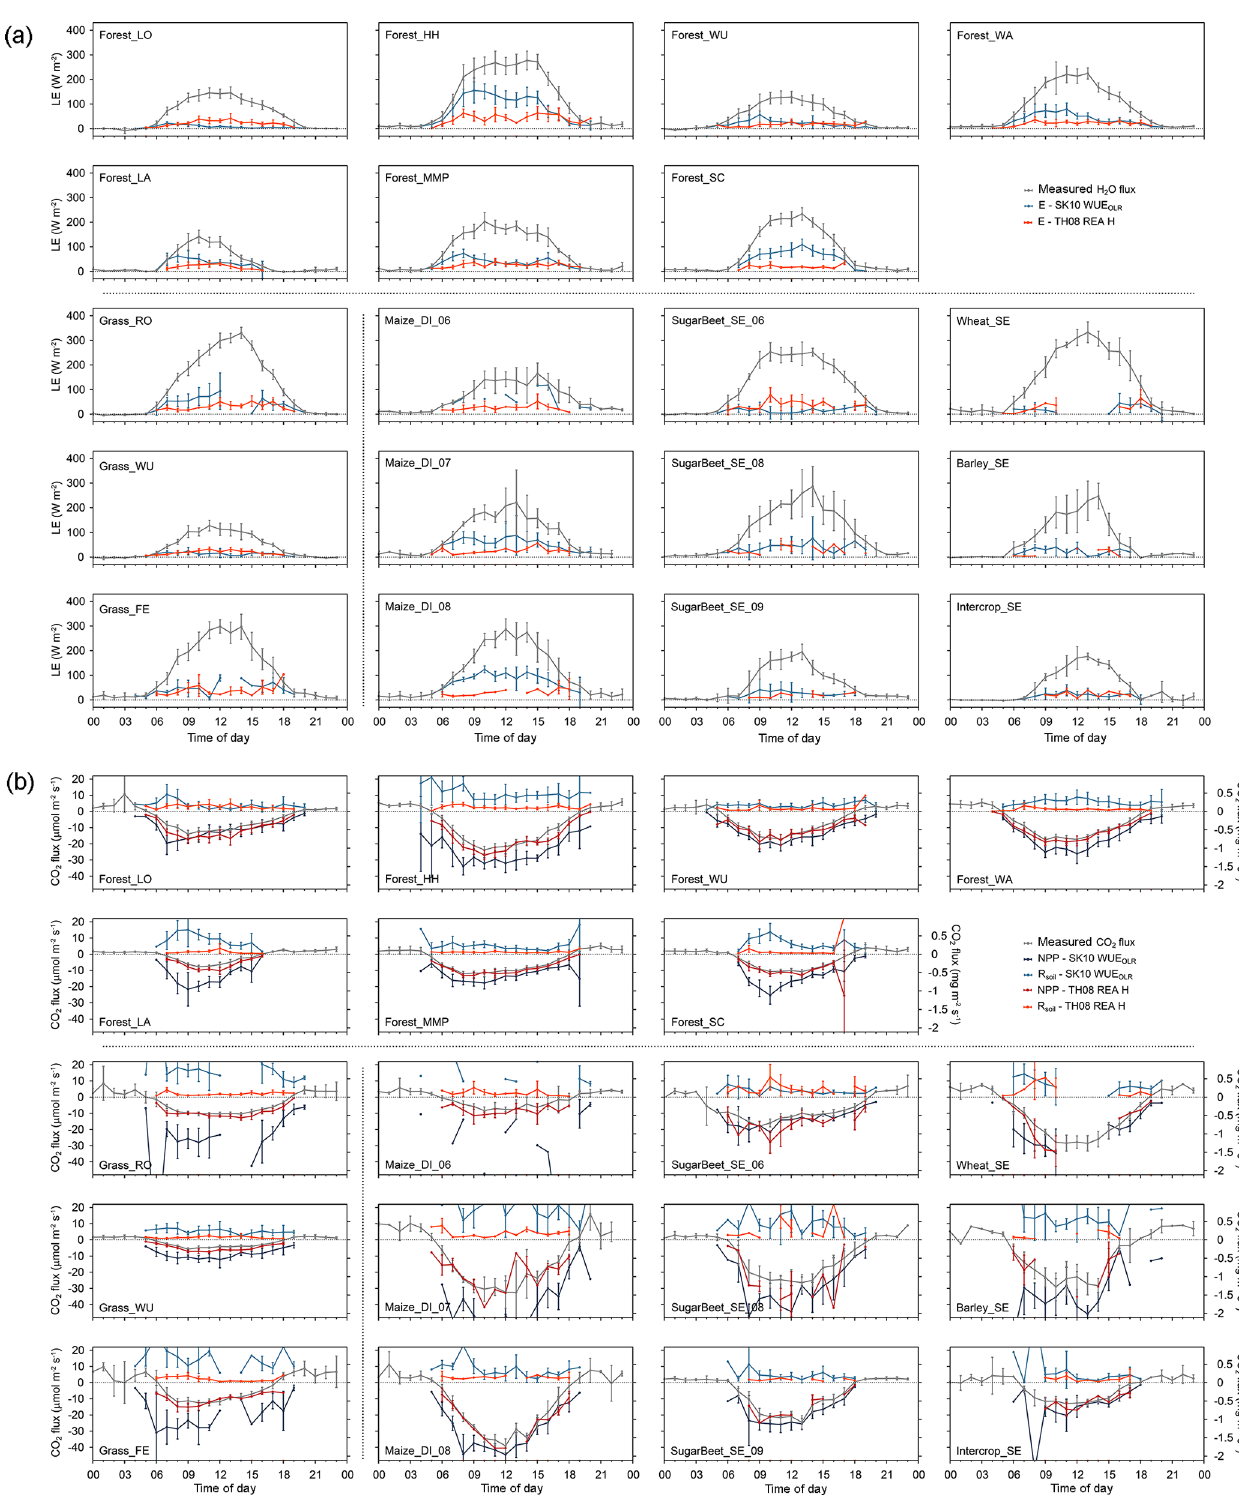
Figure 4. Diurnal dynamics of source partitioning results for (a) H 2 O and (b) CO 2 fluxes for all study sites and for the approach after Scanlon and Kustas (2010; SK10) with WUE OLR and after Thomas et al. (2008; TH08) with REA H (see text for description; LE: latent heat flux; E : evaporation; NPP: net primary production; R soil : soil respiration). Error bars indicate the 95% confidence intervals of the mean